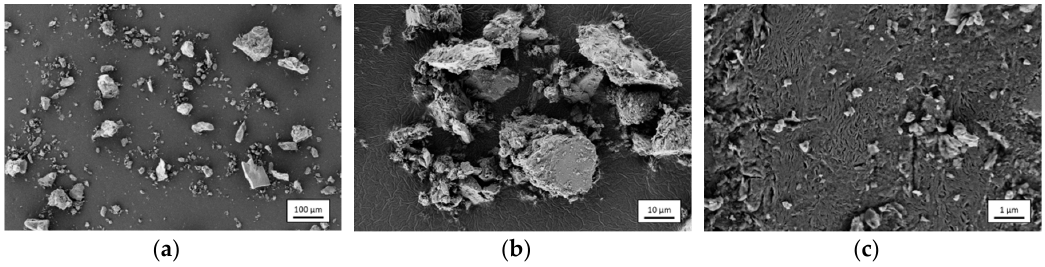
Figure 2. SEM images of as-received EAC-1 powder at ( a ) 100×, ( b ) 1000×, and ( c ) 10,000× magnification (SE detector).